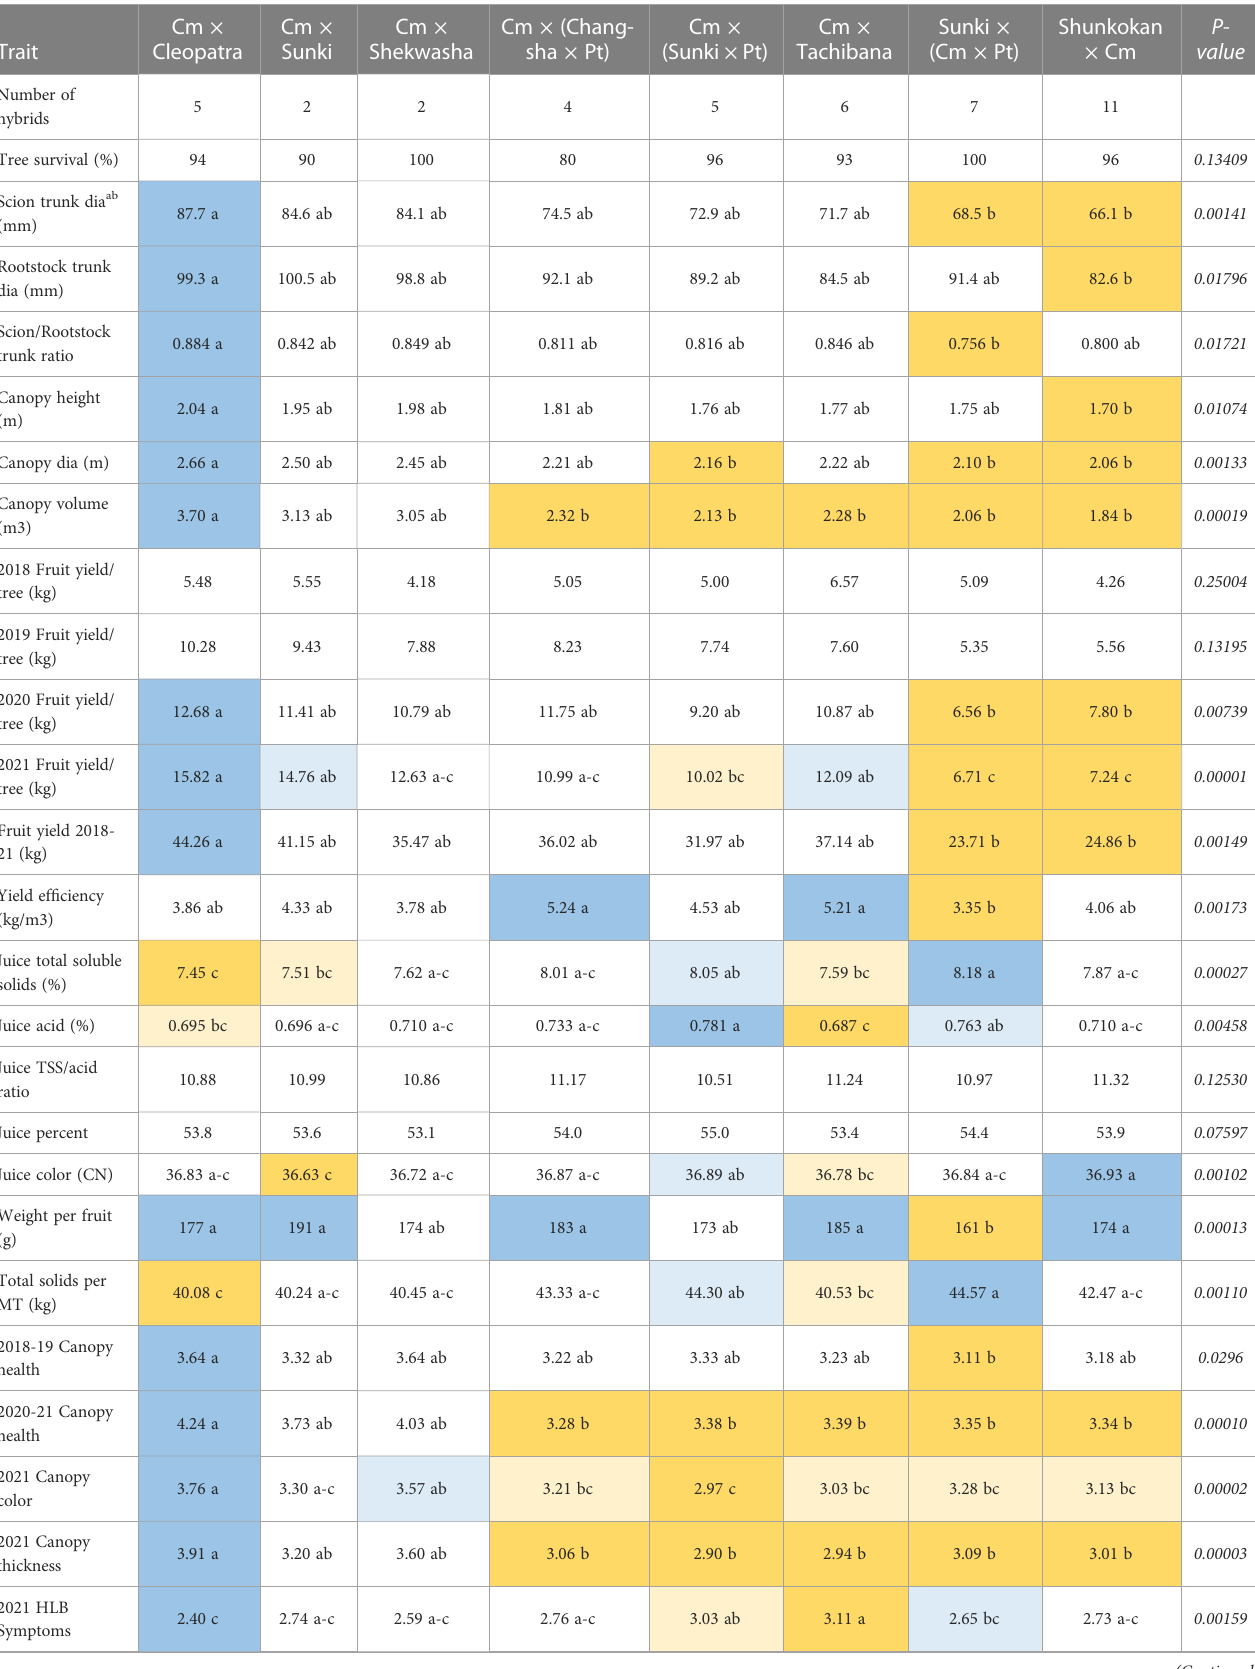
TABLE 7 Rootstock parentage effects on traits.